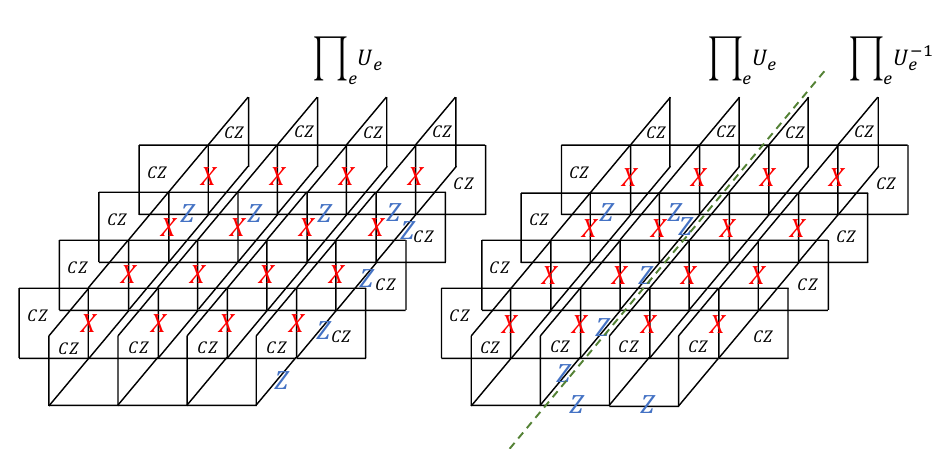
(cid:81) U with the orientation re- e